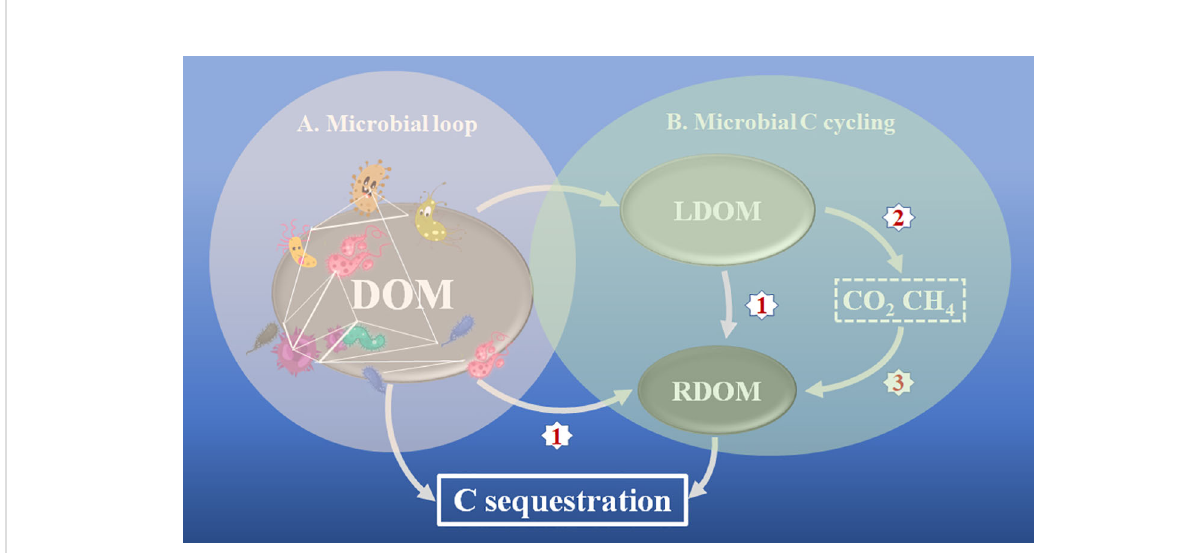
FIGURE 1 A conceptual framework for understanding C sequestration mechanisms in the marine ecosystem. (A) Biotic interactions are shown as complex networks between marine organisms (including macro-organisms and micro-organisms) affecting DOM dynamics. C sequestration is mainly driven by the biological pump (BP) mechanism. (B) Microbially-driven DOM degradation and transformation are largely explained by the microbial carbon pump (MCP) mechanism. The red numbers (1, 2 and 3) indicate possible future strategies for enhancing C sequestration in the marine ecosystem. DOM, dissolved organic matter; LDOM, labile dissolved organic matter; RDOM, refractory dissolved organic